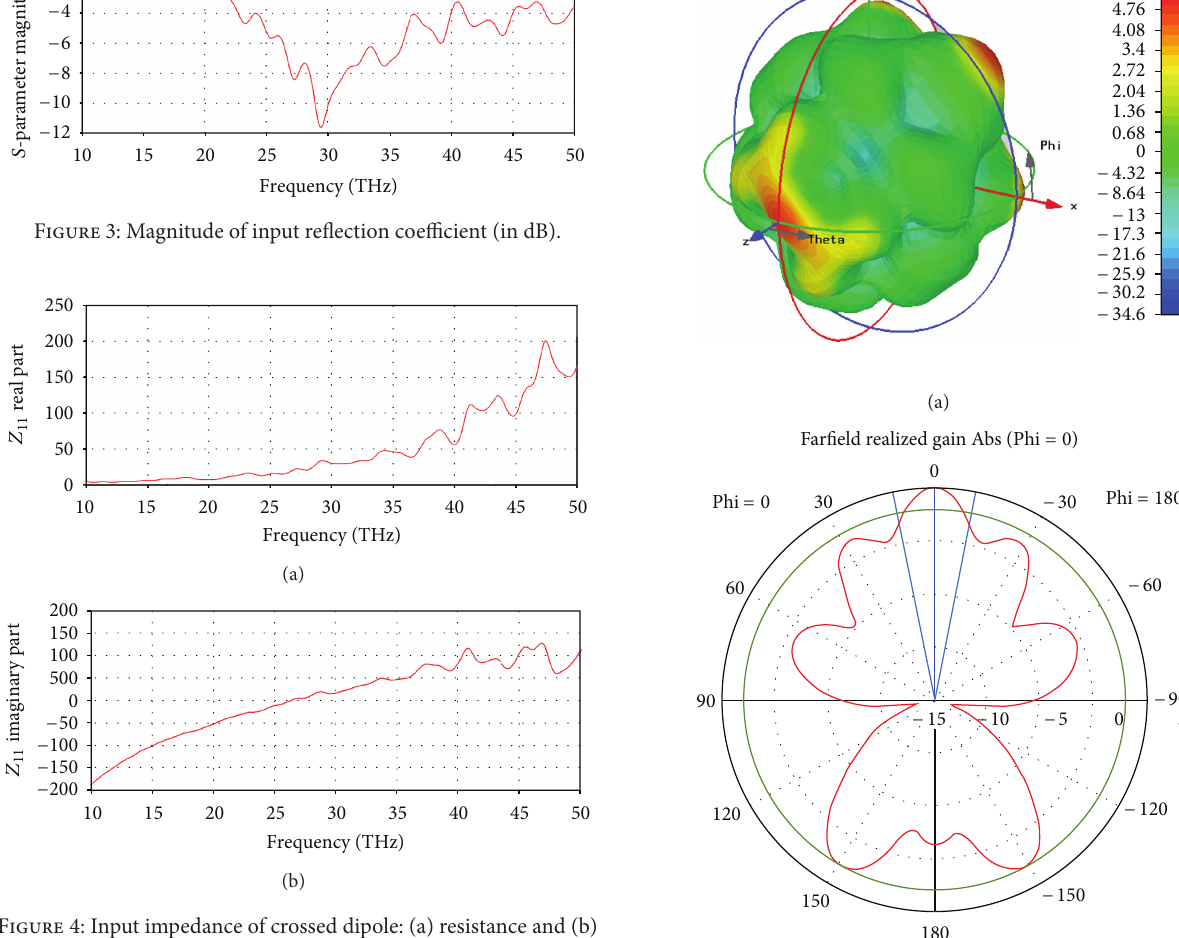
Figure 4: Input impedance of crossed dipole: (a) resistance and (b) reactance.